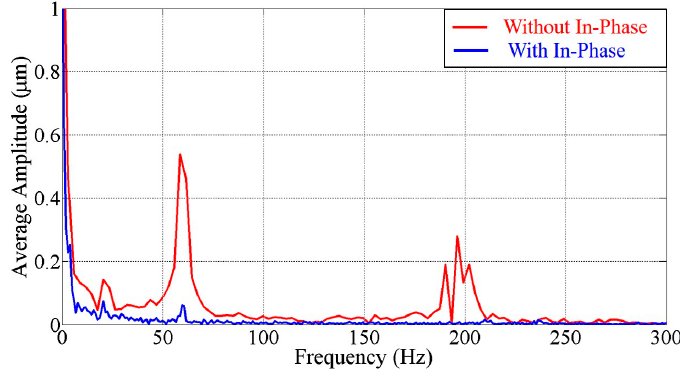
Figure 5. The frequency spectrum without and with in-phase noise cancelation.